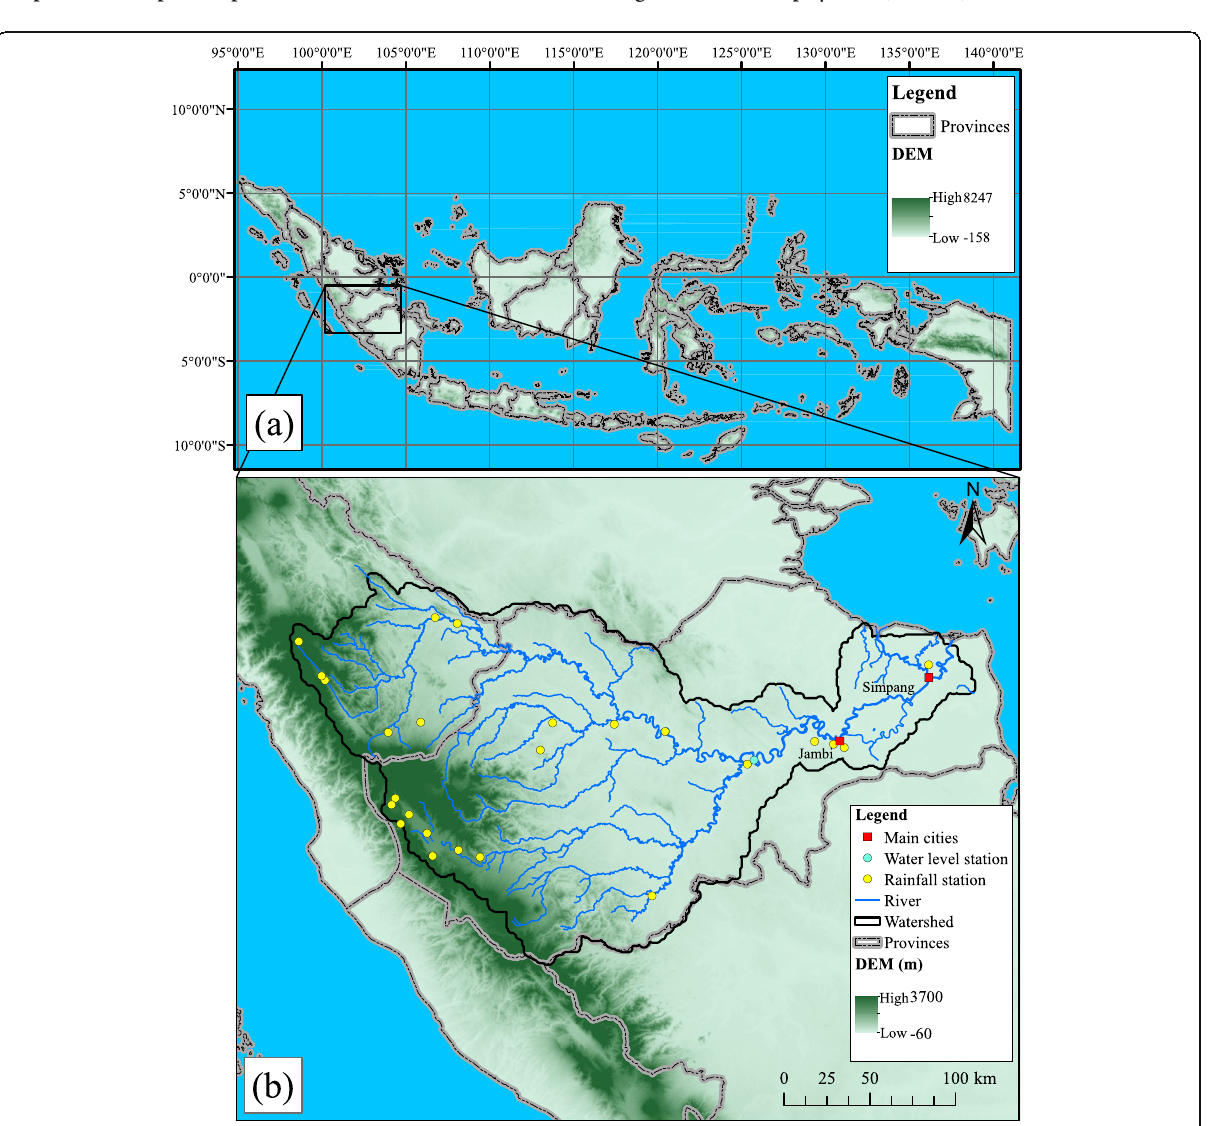
Fig. 1 Maps of the study area. a Indonesian Maritime Continent and b the Batanghari River Basin in Sumatra